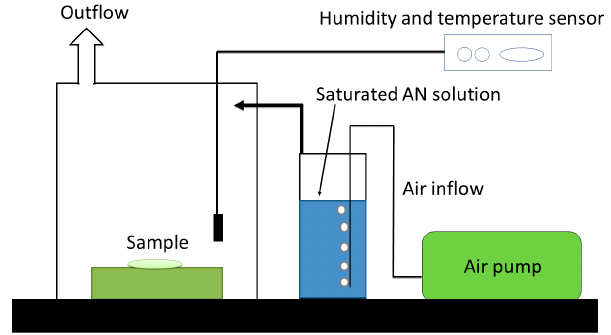
Figure 2. Experimental setup for moisture absorption test. The sample is in an enclosed container exposed to wet air and weighted periodically.